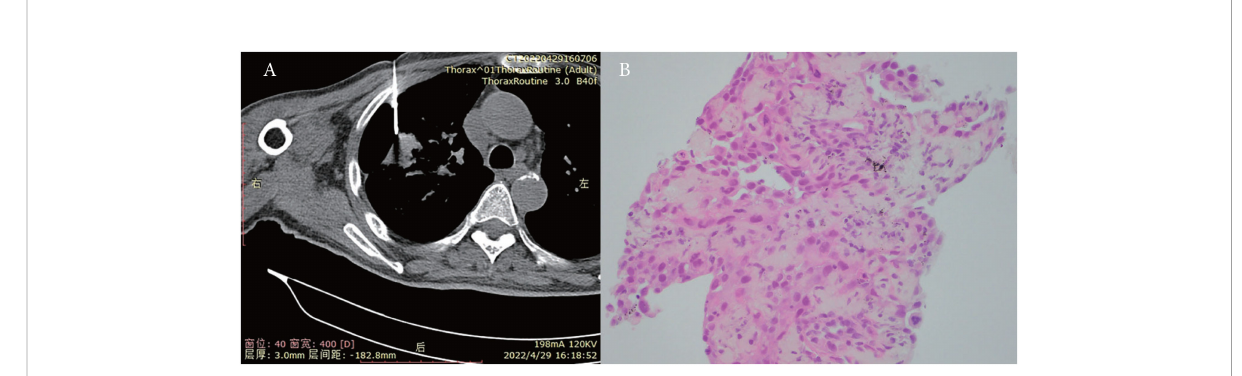
FIGURE 2 (A) Percutaneous biopsy of lung lesions guided by fusion CT. (B) Photomicroscopy with H&E (hematoxylin and eosin) staining presented unusual epithelioid